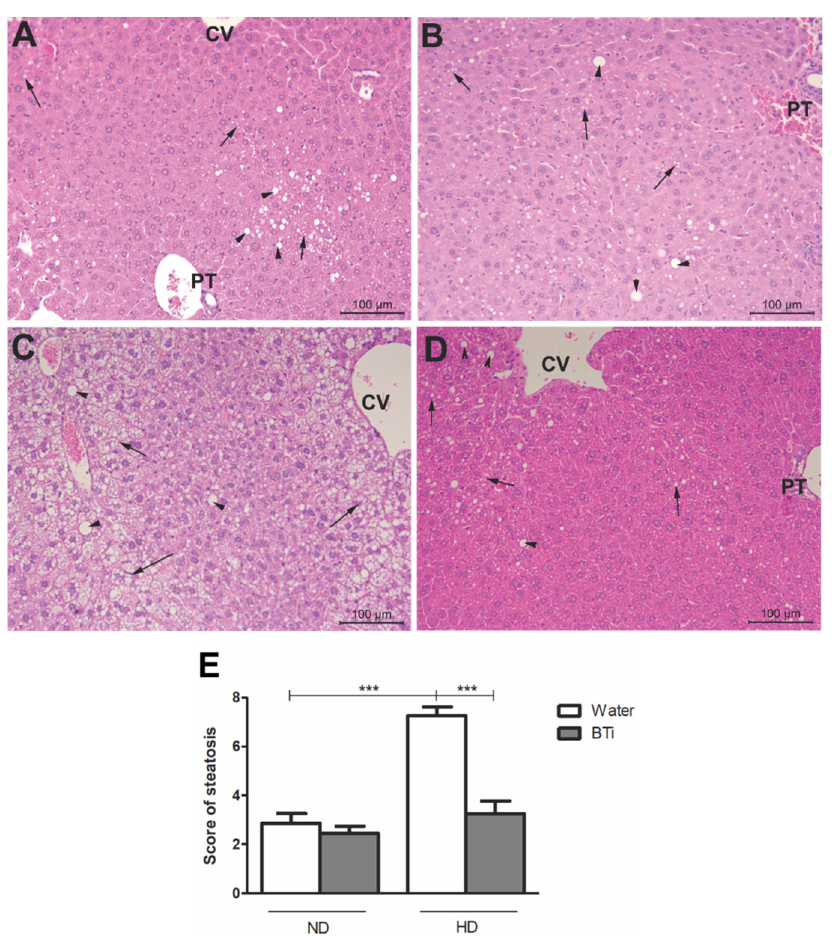
Figure 2. Effect of BTi treatment on liver histology. Histological sections stained with Hematoxylin- eosin. 20× magnification. ( A ) ND + water, ( B ) ND + BTi, ( C ) HD + water, ( D ) HD + BTi and ( E ) Score of steatosis. CV: Central lobular vein, PT: portal triad, Arrowhead: macrovesicular steatosis, Long arrow: microvesicular steatosis. Results expressed as median score, n = 5/group. Absence of lesion— 2 points; mild injury—4 points; moderate injury—6 points and severe injury—8 points. ND: normolipid diet. HD: high fat diet. BTi: B.trimera infusion. *** p < 0.001. Kruskall–Wallis, followed by the Mann-Whitney post-test.